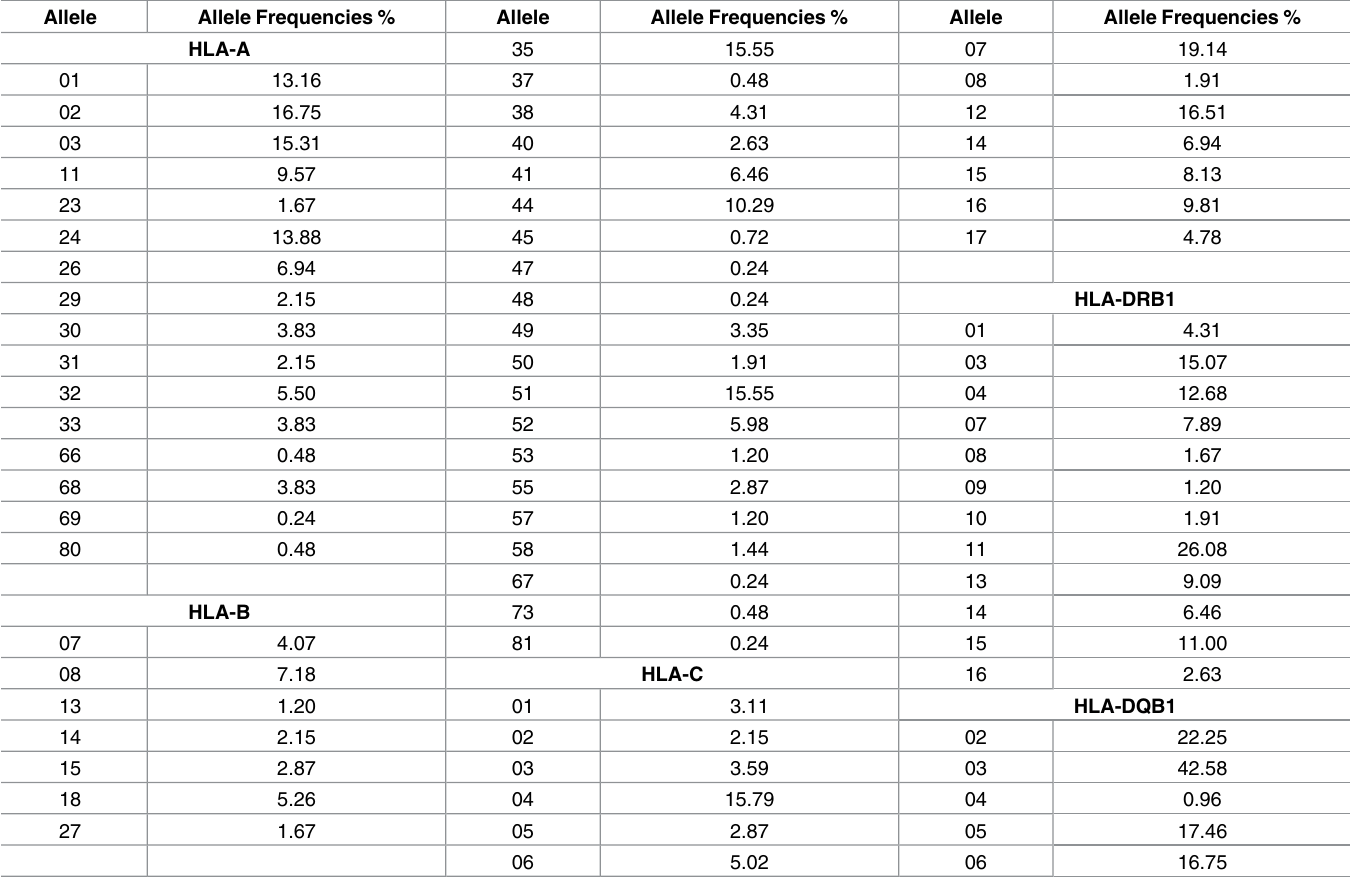
Table 3. HLA-A, -B, -C, -DRB1, and -DQB1 allele frequencies in Iraq Kurds